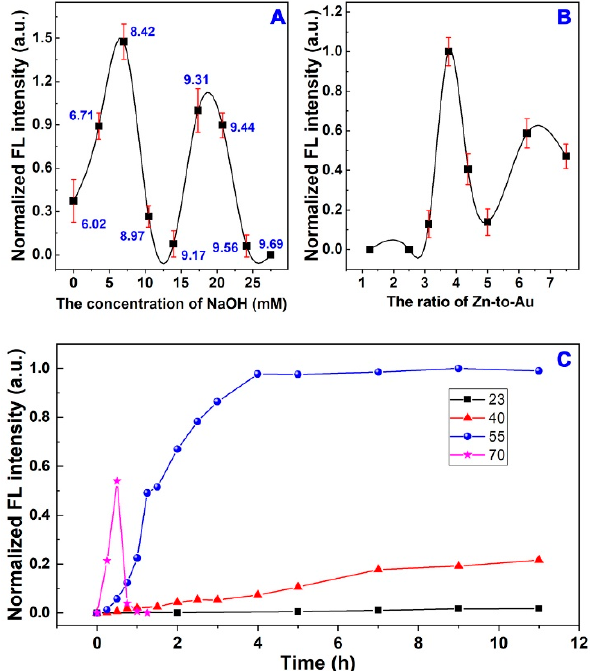
Figure 1. The effect of pH ( A ) and Zn-to-Au ratio ( B ) on the fluorescence intensity of Au NWs. ( C ) The change of fluorescence intensity at different temperature during synthesis of Au NWs.